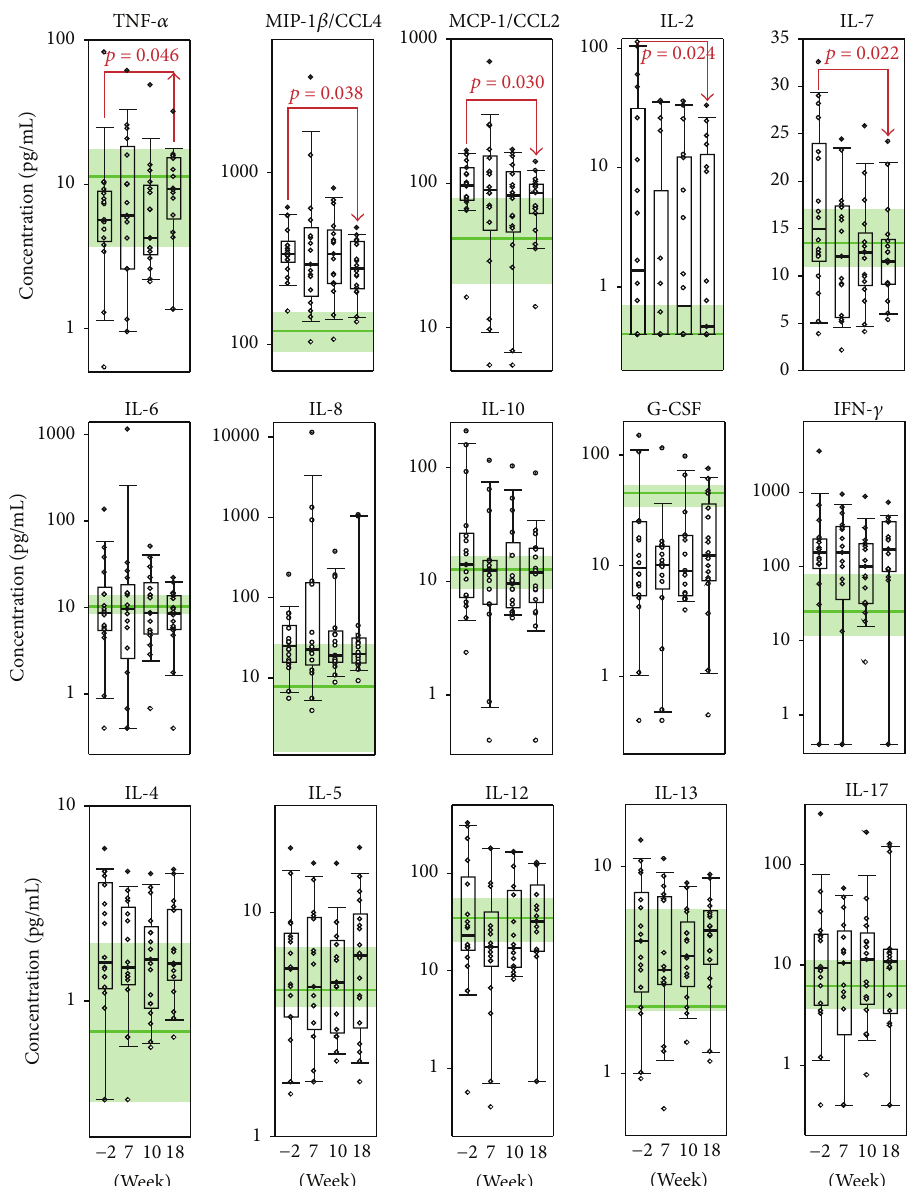
Figure 1: Serum levels of cytokines (pg/mL) in the treatment group at the time of the screening ( − 2 weeks), 7, 10, and 18 weeks. The interquartile range is shown by boxes. The median in each group is shown by the bold line. Bars represent 95% confidence interval. Statistically significant differences with their respective 𝑝 values are indicated. The green line represents cytokine levels in healthy individuals. The green- colored zone corresponds to the interquartile range in healthy individuals according to the previously reported data (see Section 2 for details). In the upper line, cytokines that had a statistically significant improvement are